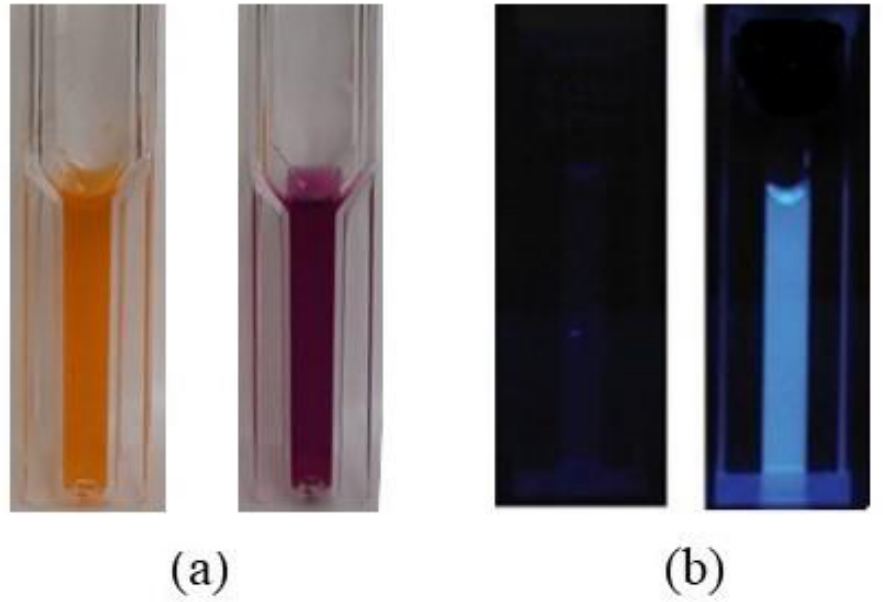
Figure 6. Florescent test of Salmonella interaction with conjugated ICGNPs ( a ) With white light. ( b ) With UV light.